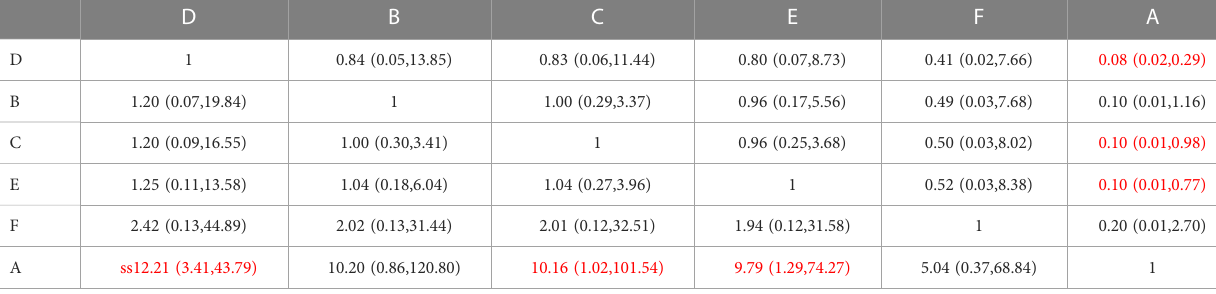
MD, standard mean difference. Red texts indicated that there were statistical difference between groups corresponding to horizontal and vertical